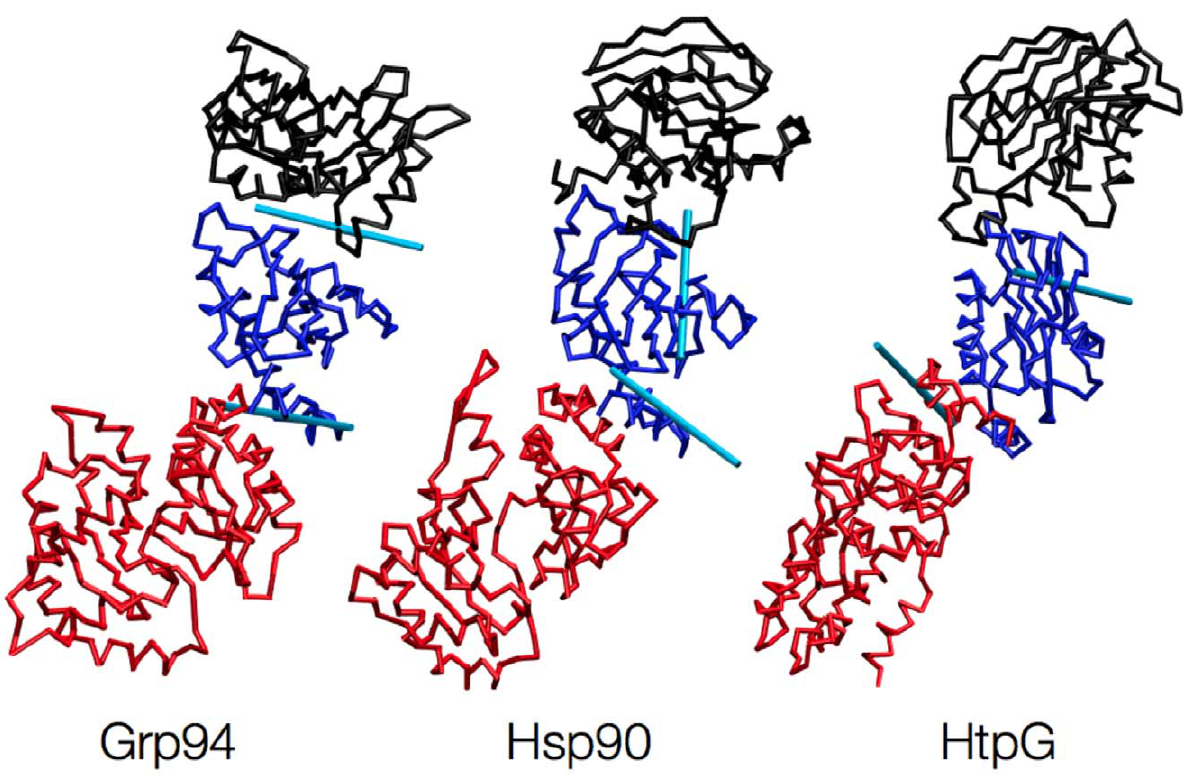
Figure 7. Different views of the optimal rotation axes identified for each part of the meta-trajectory corresponding to a specific chaperone, separately. The template structures have different configurations, each one being the closest to the corresponding chaperone’s protomer average structure.